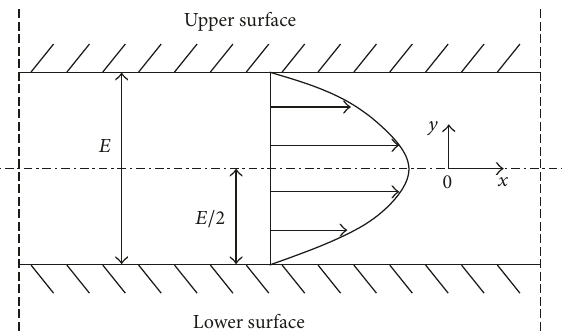
Figure 2: Flow velocity distribution in a parallel plate